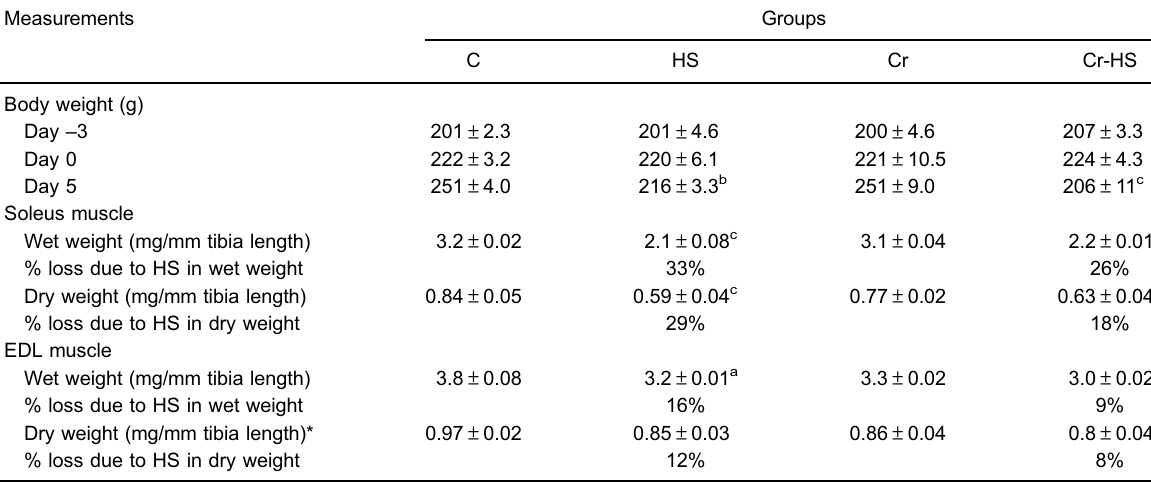
Table 1. Body weight and muscle masses of soleus and extensor digitorum longus (EDL)